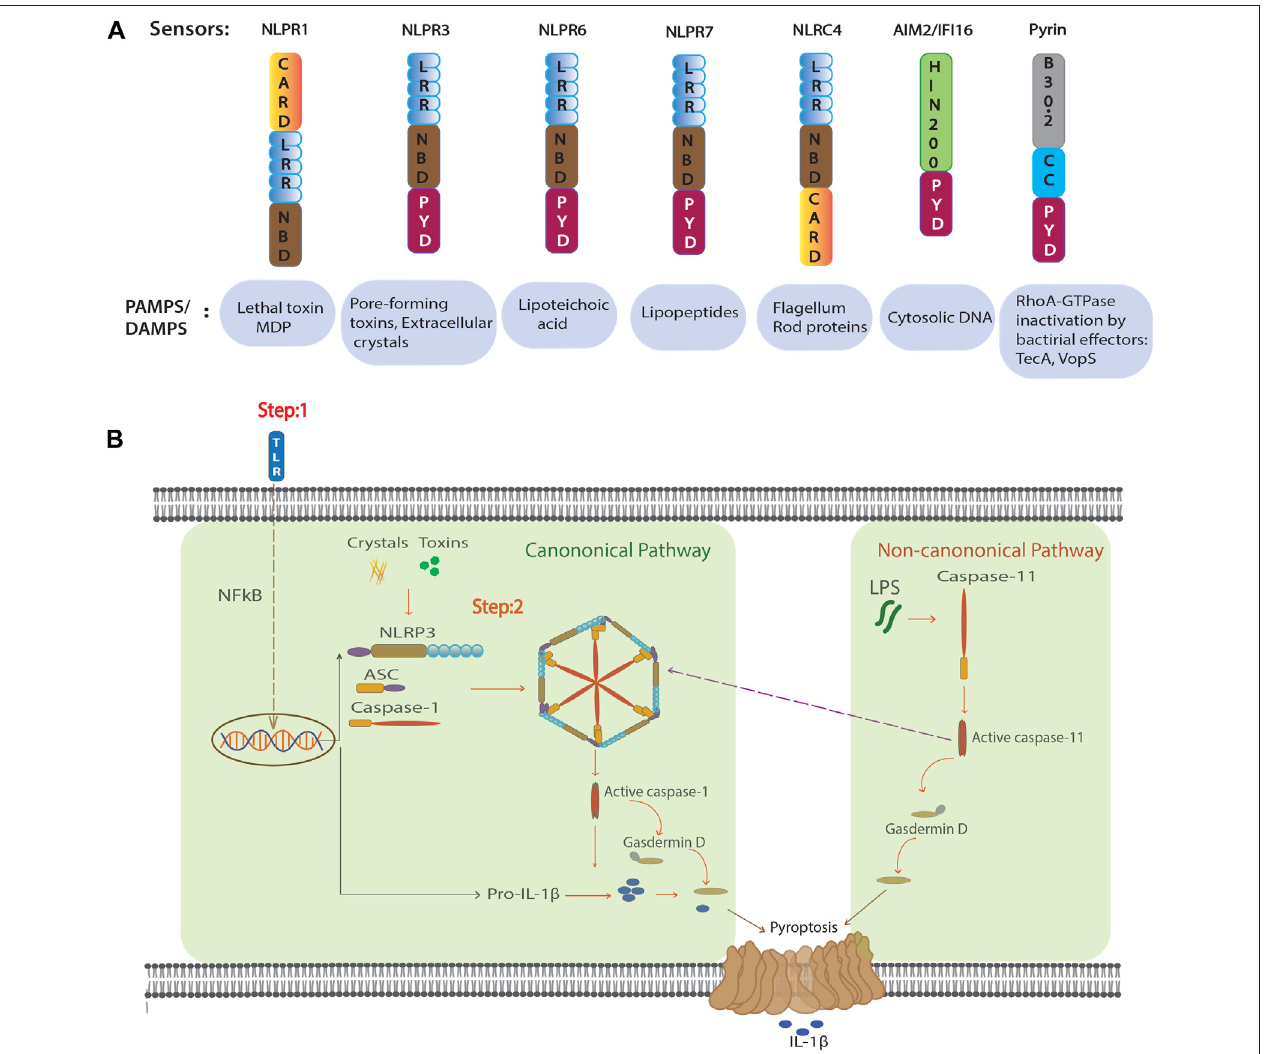
FIGURE 1 | In fl ammasome con fi guration and activation. (A) Domain structure of the NLR proteins that form active in fl ammasomes and non-NLR in fl ammasome AIM2andPyrin(above).Knownactivatorsofin fl ammasomeformation(below). (B) Suggestedactivationschemeforcanonicalandnon-canonicalNLRP3in fl ammasome formation.Inthecanonicalpathway,NF- κ B – activationbyTLRligationinthe fi rststepincreasestranscriptionandtranslationofNLRP3andpro-IL-1 β .Inthesecondstep, NLRP3 agonists such as MSU crystals or pore forming toxins induce in fl ammasome formation and thus allow autocleavage and activation of caspase-1. Matured caspase-1 induces cellular activation by cleavage of the cytokines IL-1 β and IL-18, and GSDMD mediated pyroptosis. In non-canonical pathway intracellular LPS binds and activates caspase-11. Active form of caspase-11 mediates GSDMD-dependent pyroptosis and further activation of NLRP3 in fl ammasome.